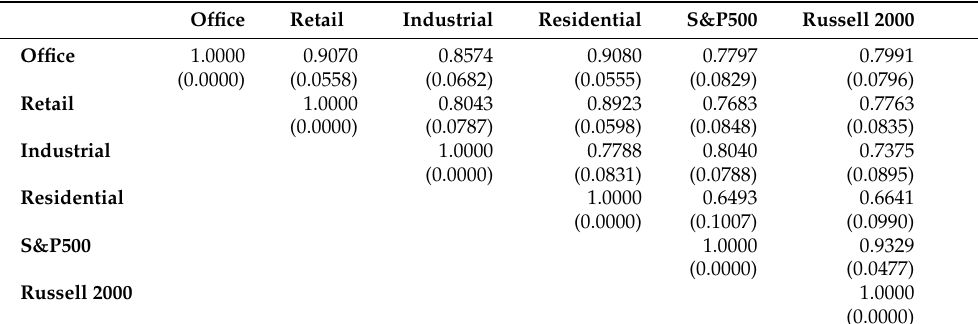
Table 1. Correlation Coefficients among Main Market and REITs Indices Returns.